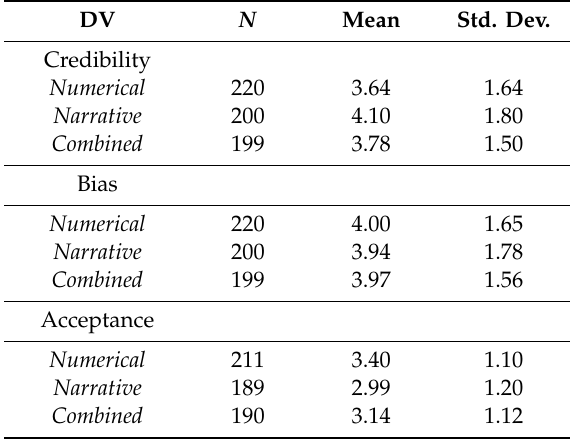
Table A2. Descriptive values per dependent variable, experimental condition.